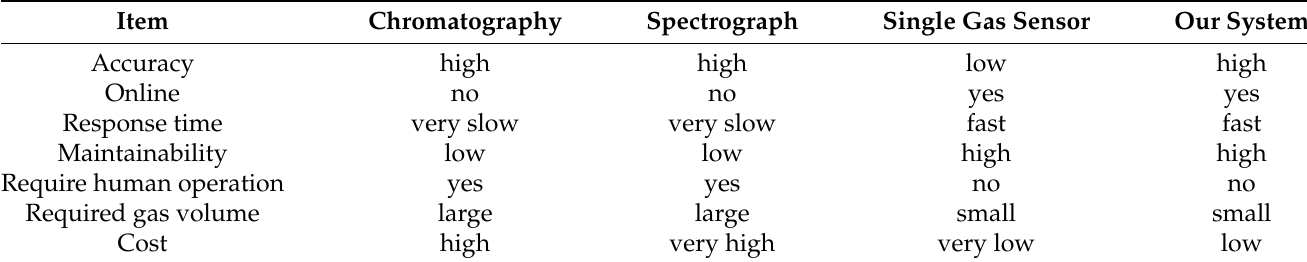
Table 5. Comparison of our system with other related